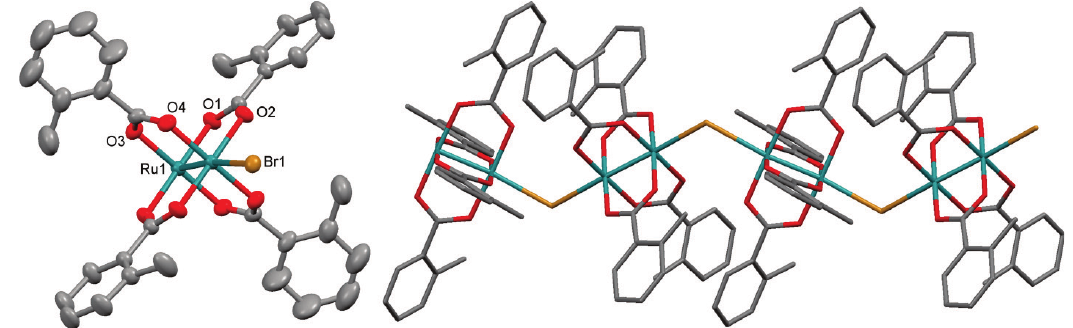
Figure 1. Left : thermal-ellipsoid representation of the paddlewheel monomer of complex 1 (50% probability ellipsoids); Right : zigzag chain. Hydrogen atoms are omitted in both cases for clarity.